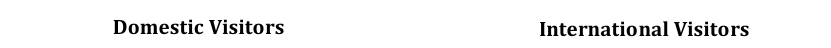
Table 3 Summary visitors’ movement